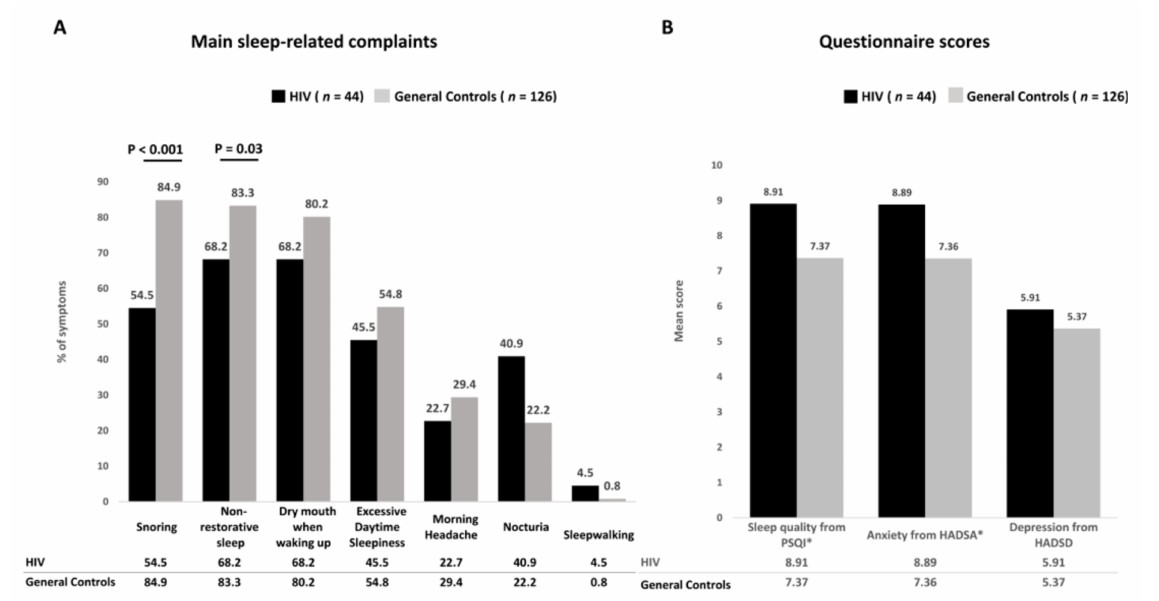
Figure 2. Frequency of main sleep-related complaints ( A ) and questionnaire scores ( B ) among HIV-infected persons compared with controls. Abbreviations: PSQI—Pittsburgh sleep quality index; HADSA—Hospital Anxiety and Depression Scale for anxiety; HADSD—Hospital Anxiety and Depression Scale for